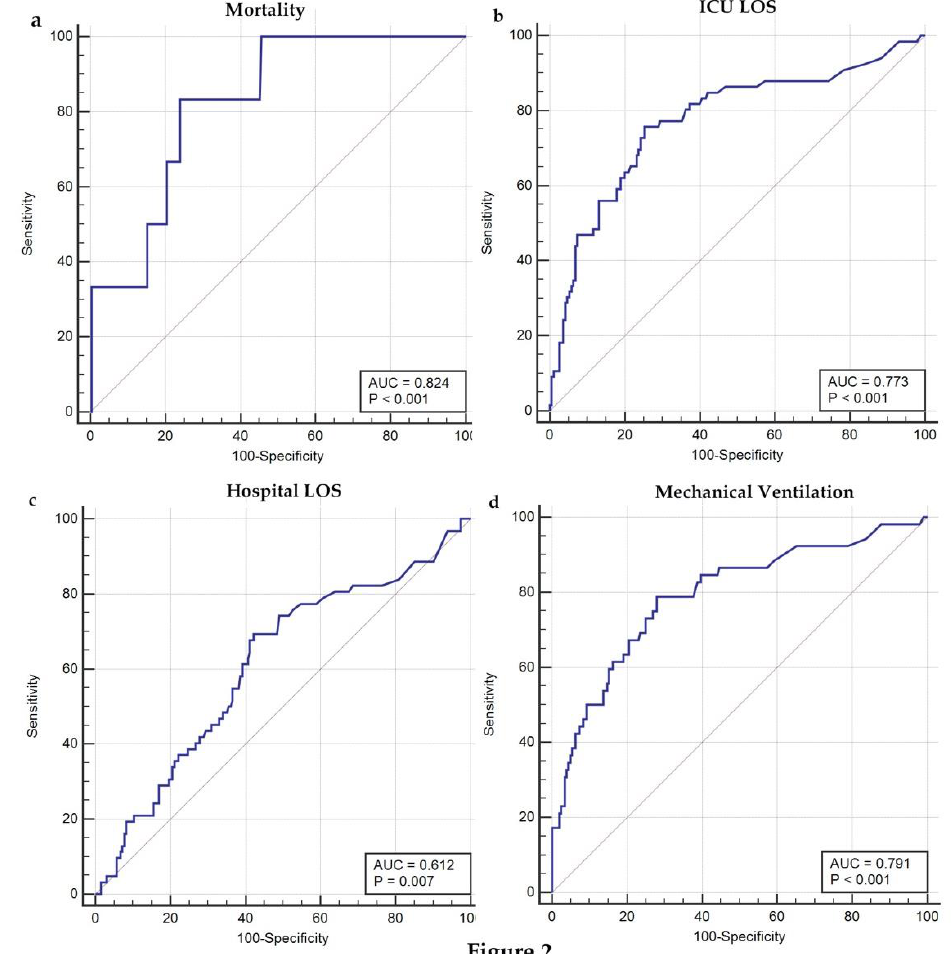
Figure 2. Receiver operating characteristic (ROC) analysis of postoperative ALT in predicting clinical outcomes for pediatric patients undergoing TCPC. ( a ) ROC curves of postoperative ALT in predicting mortality; ( b ) ROC curves of postoperative ALT in predicting postoperative ICU LOS; ( c ) ROC curves of postoperative ALT in predicting postoperative hospital LOS; ( d ) ROC curves of postoperative ALT in predicting duration of mechanical ventilation for pediatric patients undergoing TCPC operation.